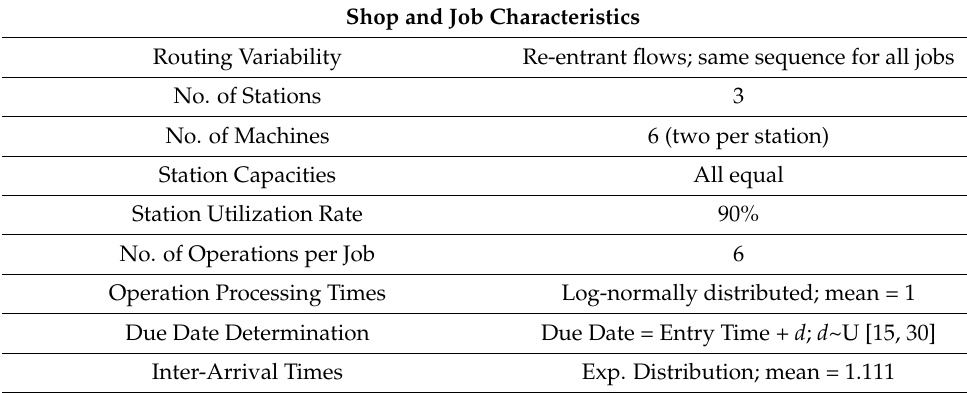
Table 1. Summary of simulated shop and job